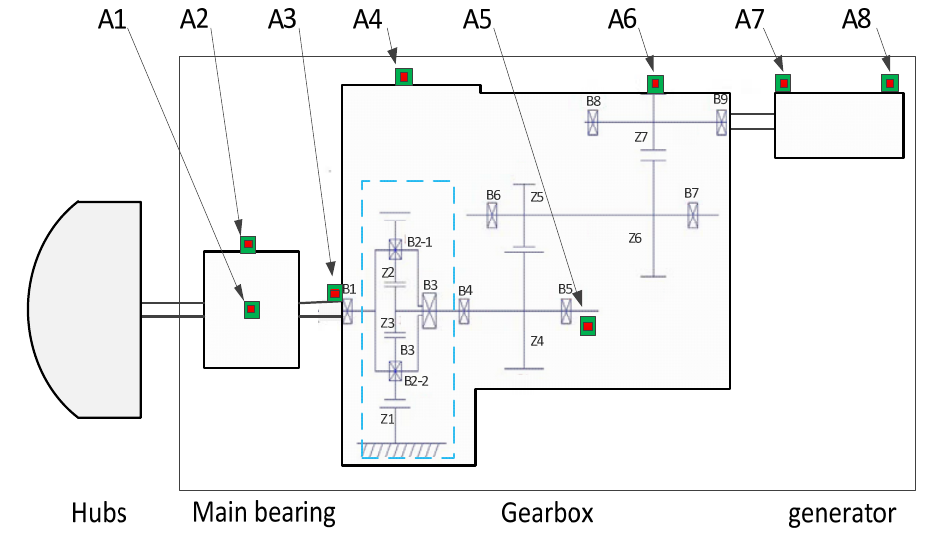
Figure 8. The distribution of the accelerometer on the wind turbine. Table 1. The detail information on the datasets.